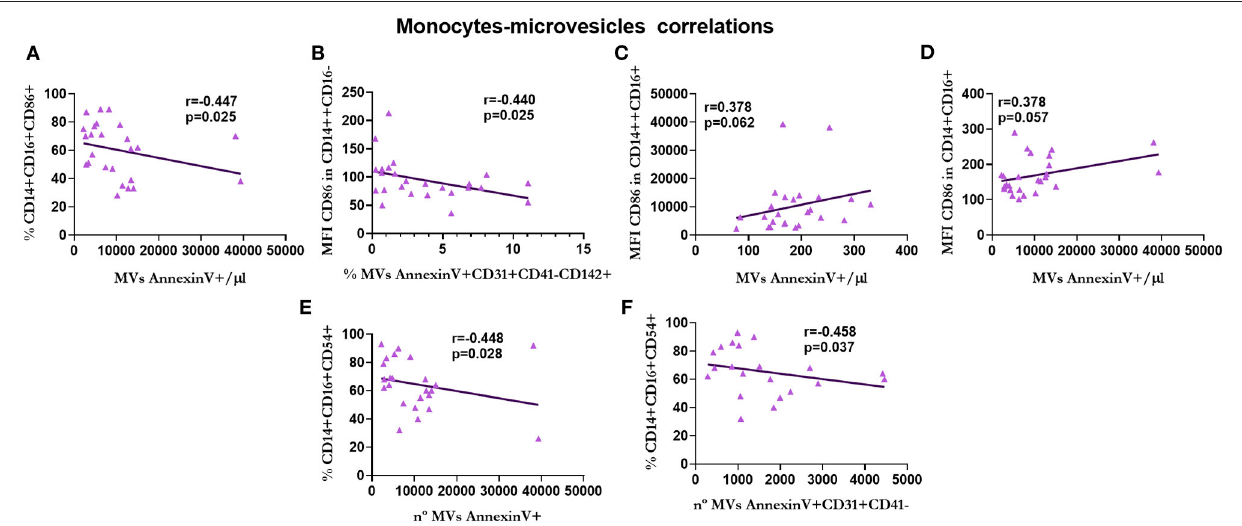
FIGURE 13 | Correlation between monocytes and microvesicles in renal transplantation. Correlations between the percentage of CD86 + non-classical monocytes and the total number of microvesicles (A) , the expression of CD86 in classical monocytes and the percentage of 142 + endothelium microvesicles (B) , the expression of CD86 in intermediate monocytes and the total number of microvesicles (C) , the expression of CD86 in non-classical monocytes and the total number of microvesicles (D) , the percentage of CD54 + intermediate monocytes and the total number of microvesicles (E) , and the percentage of CD54 + intermediate monocytes and the number of endothelium microvesicles (F) are